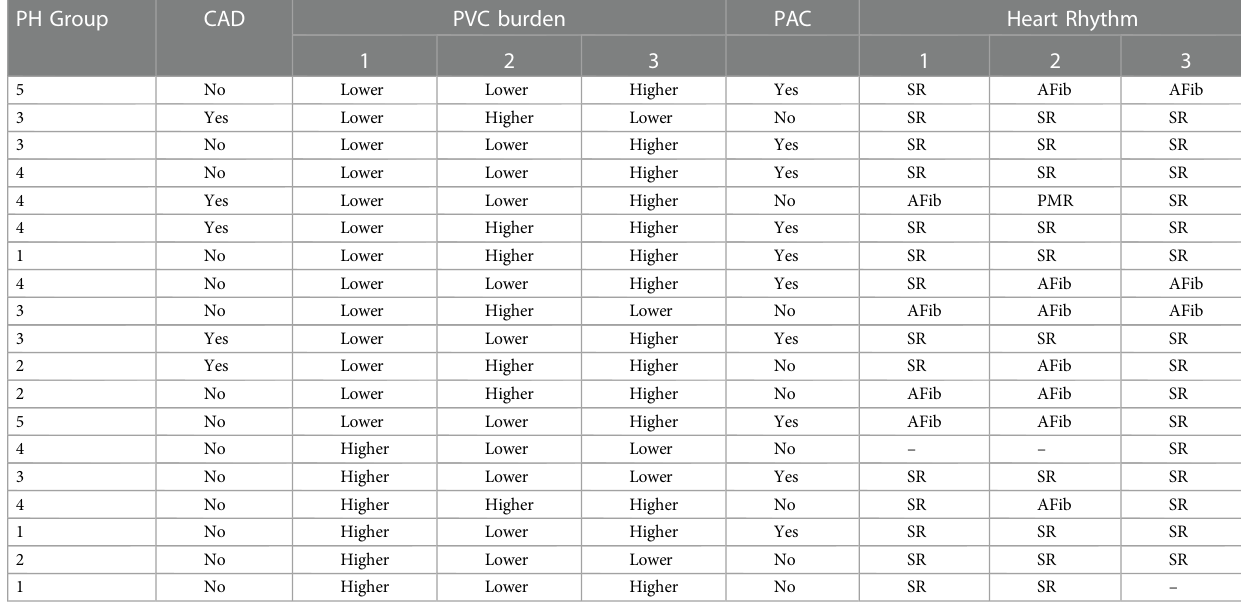
TABLE 6 Patients with non-sustained ventricular tachycardia (nsVT) during Holter electrocardiogram follow-up. PH Group